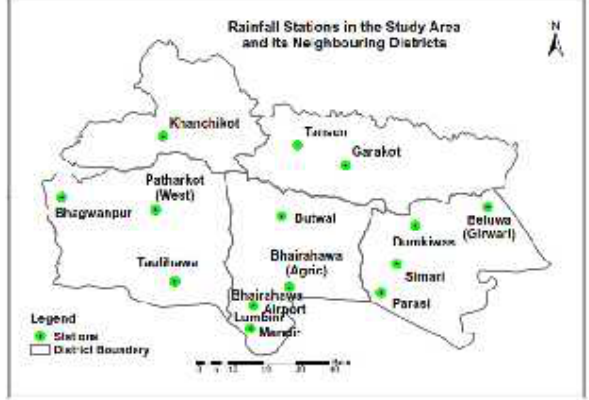
Figure 3. Rainfall station site